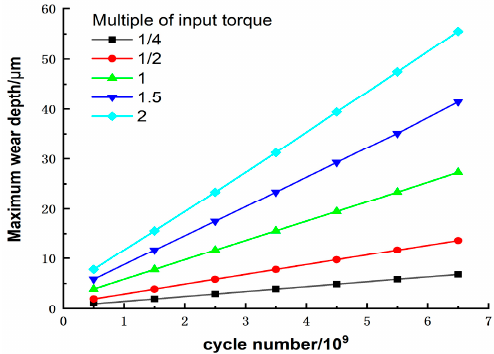
Figure 15. Effect of torque on maximum wear depth without offset.